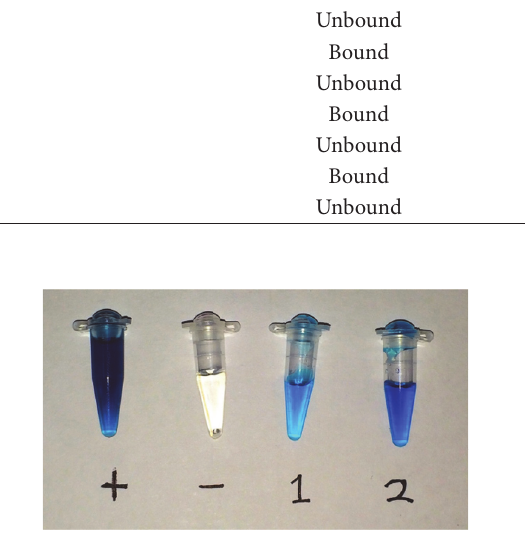
Figure 1: In-tube ELISA tests in CA125-coated PCR tubes. Positive control (+) contains 30 𝜇 L of 8000 U/mL CA125. Negative control ( − ) was incubated with PBS overnight. Tube 1 was incubated with 30 𝜇 Lof8000 U/mLCA125overnightat4 ∘ C.Tube2contained30 𝜇 L of 8000 U/mL CA125 and was dried without heating on a SpeedVac for 4hr. Image taken with an iPhone 5s.